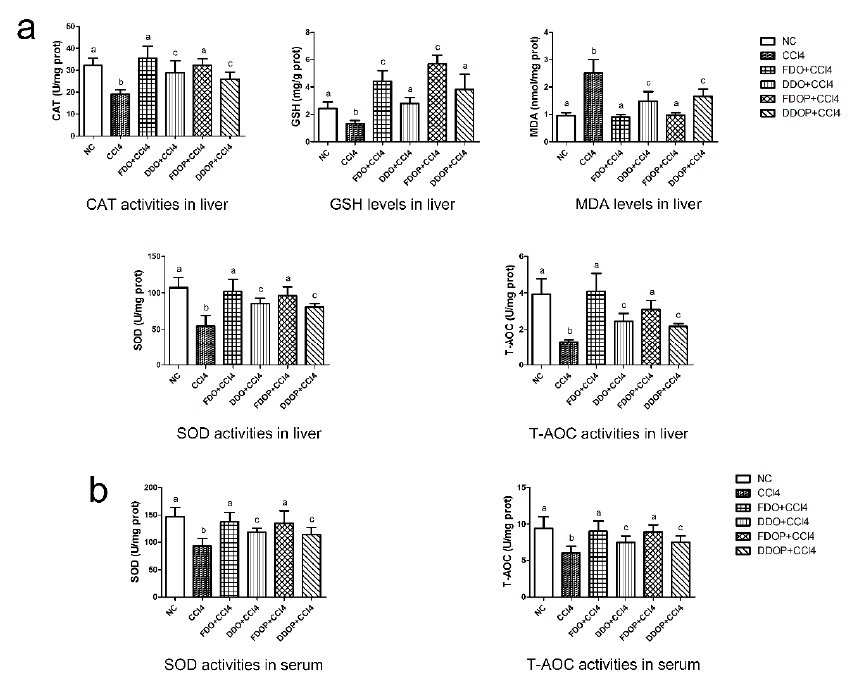
Figure 2. Effects of FDO, DDO, FDOP (fresh Dendrobium officinale polysaccharide), and DDOP (dried Dendrobium officinale polysaccharide) on antioxidant parameters including CAT activities, GSH levels, MDA levels, SOD activities, and T ‐ AOC activities in the liver, ( a ) and SOD and T ‐ AOC) activities in serum ( b ) of CCl 4 ‐ treated mice. All data were presented as means ± SD ( n = 6) and analyzed with one ‐ way analysis of variance (ANOVA) followed by least significant differences (LSD) multiple comparison and Dunnett’s T3 tests. Different alphabets (a–c) in pictures showed a significant difference ( p < 0.05). NC: negative control; CCl 4 , tetrachloromethane, widely used to induce toxic liver injury in various experimental animals.